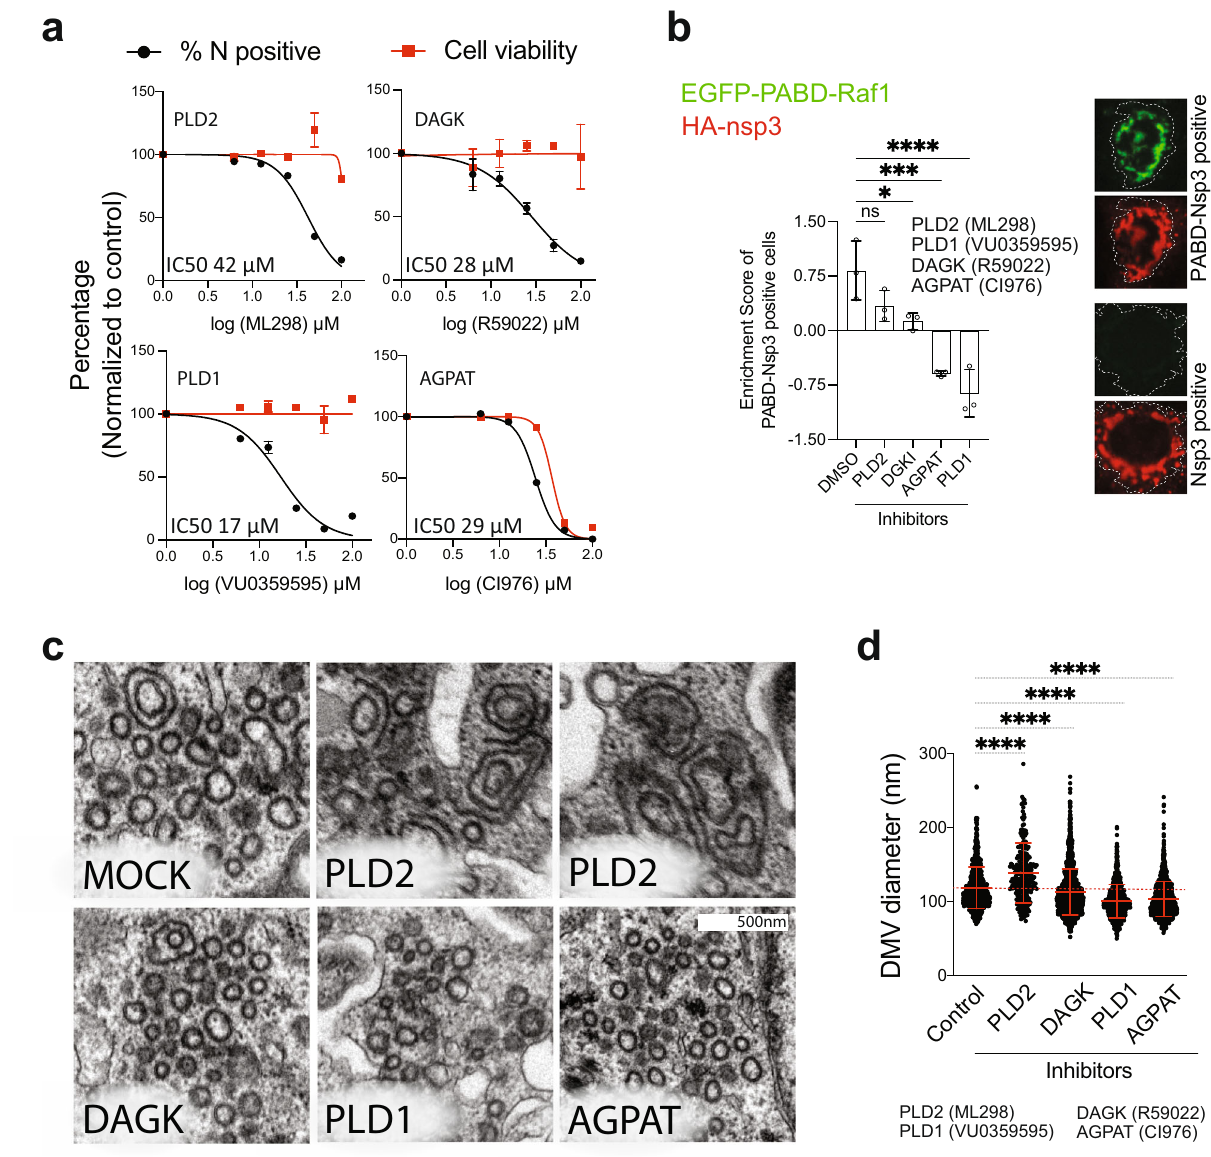
Fig. 8 Role of alternative PA synthesis pathways for SARS-CoV-2 replication and DMV formation. a Alternative PA synthesis pathways are important for SARS-CoV-2 replication. Calu-3 cells were infected with SARS-CoV-2 (MOI = 5) in the presence of AGPAT, PLD1/2, or DAGK inhibitors. Cells were fi xed 24 h post infection, stained with nucleocapsid-speci fi c antibody, and the percentage of infected cells was quanti fi ed using CellPro fi ler. Cell viability and percentage inhibition are plotted as dose-response curves and IC50 values are given on the top of each panel. Data are represented as mean ± SD from a representative experiment; two biologically independent experiments gave similar results. b AGPAT, PLD and DAGK inhibitors reduce PA accumulation at nsp3-positive structures. Huh7-Lunet cells were transfected with SARS-CoV-2 HA-nsp3-4-V5 and EGFP-PABD-Raf1 encoding plasmids, followed by the addition of a given inhibitor 4 h after transfection. Twenty-four hours later, cells were fi xed and HA-nsp3 was detected with an HA-speci fi c antibody. EGFP- PABD and HA-nsp3 were visualized by confocal microscopy. A semi-automated machine-learning-based classi fi er was trained to separate HA-nsp3/PABD double-positive structures from HA-nsp3 single positive structures. Enrichment score for HA-nsp3/PABD double-positive structures showing the up or downregulation of double-positive cells in different samples is plotted and statistical signi fi cance was calculated using ordinary one-way ANOVA. ns, p = 0.1231, * p = 0.0241, *** p = 0.0002, **** p = 6.45177E-5. Data are represented as mean ± SD from three biologically independent experiments. c Decrease of SARS-CoV-2 DMV diameter by AGPAT, PLD, and DAGK inhibitors. Huh7-Lunet/T7 cells were transfected with the plasmid encoding HA- nsp3-4-V5 and fl uorescent NeonGreen, followed by addition of inhibitors 4 h after transfection. Twenty-four hours later, cells were fi xed, NeonGreen positive cells were recorded and examined by EM. Representative images are shown for each condition. d Number and morphology of DMVs were determined for at least seven cell pro fi les per condition. DMV diameters are plotted and statistical signi fi cance was calculated using ordinary one-way ANOVA. **** p = 4.03773E − 25. Data are represented as mean ±